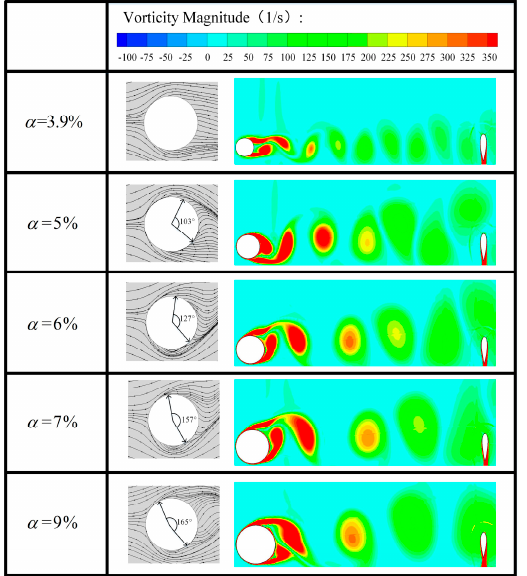
Figure 10. Instantaneous vortices contours of central rotating shaft and the time-averaged streamlines for the last 10 operating revolutions of VAWT with respect to different values of α .